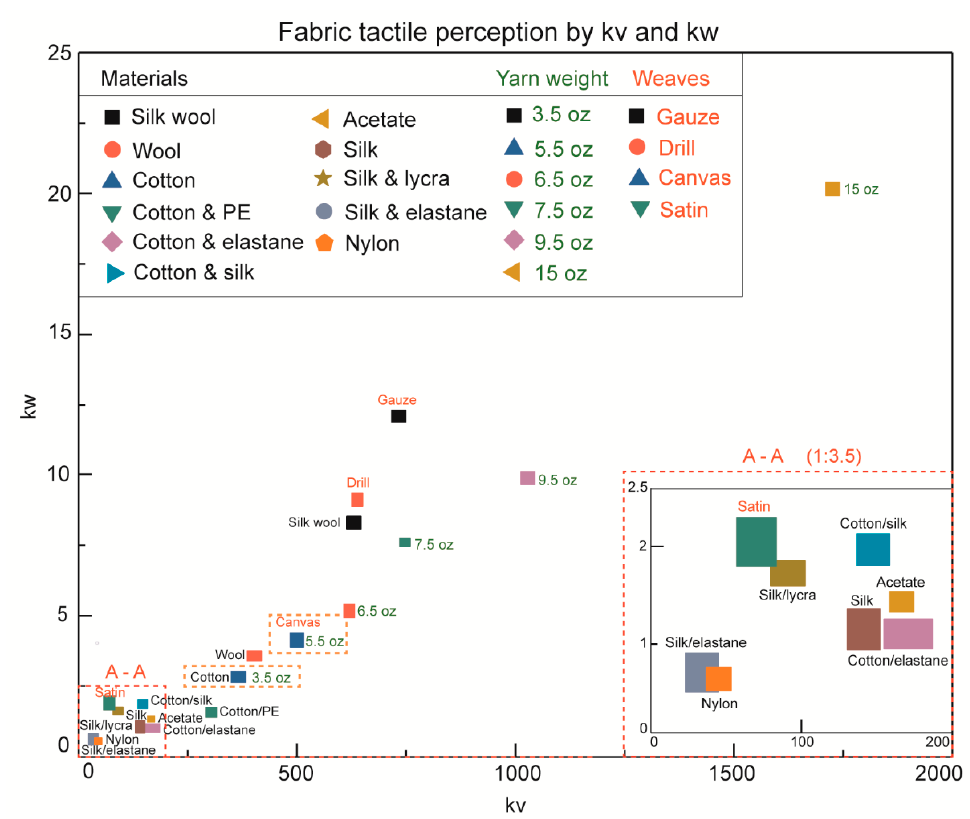
Figure 7. Tactile discrimination of 21 common textile fabrics on the physical properties of material, yarn weight and weave pattern, while they are distributed by our approach of kv and kw values. An enlarged window (A-A 1:3.5) illustrates the tactile perception overlaps of some textile fabrics.